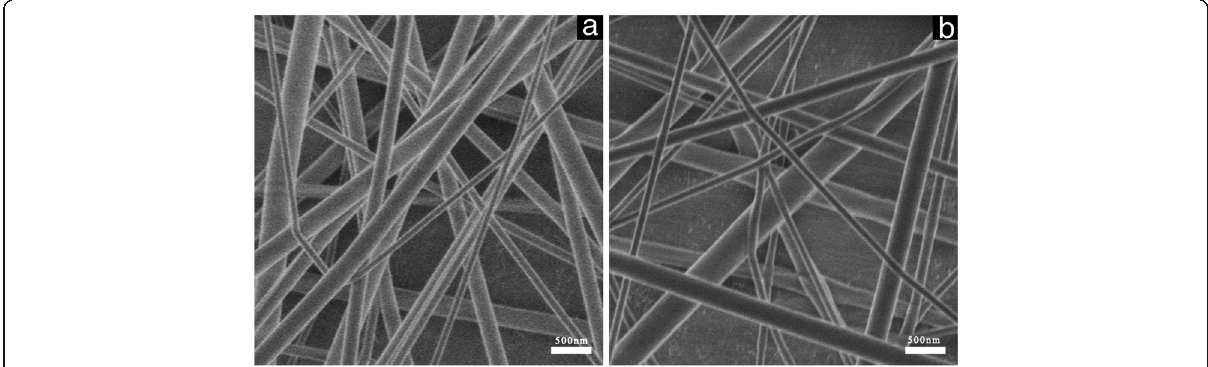
Fig. 2 SEM micrograph of the a typical blank PCL fibers and b cis -DIDP@PCL fibers